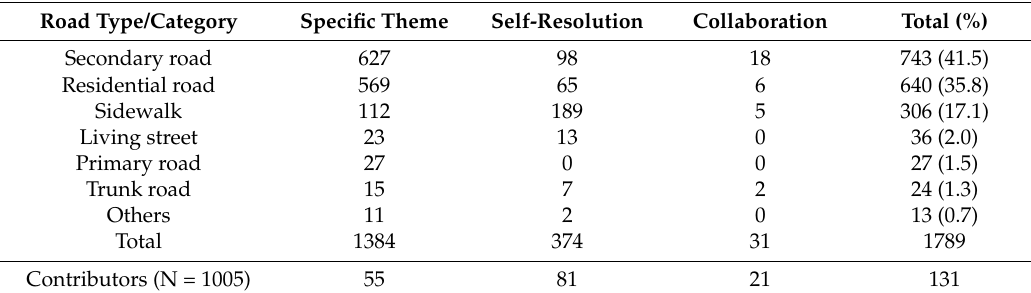
Table 4. Comparing citizen collaboration to fix road